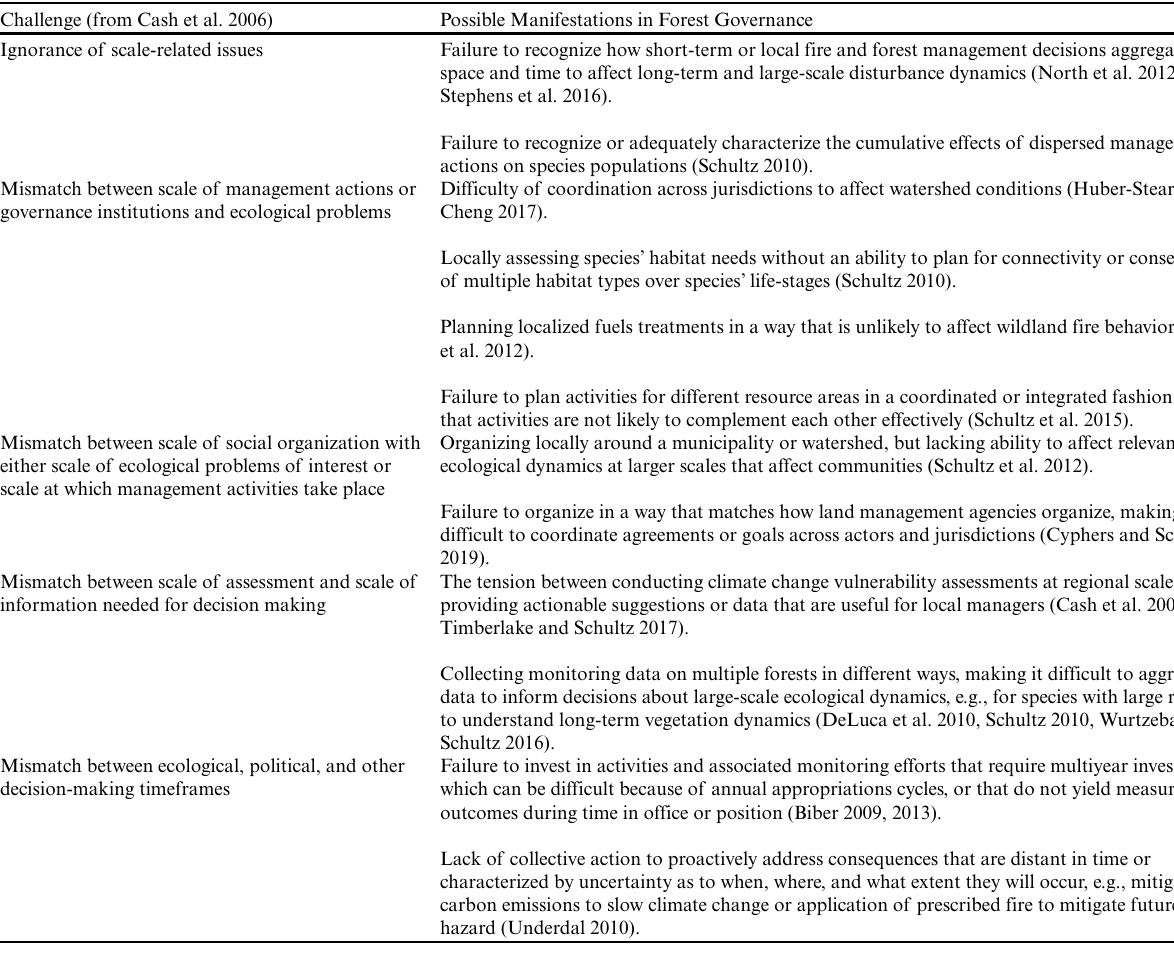
Table 1 . Types of scale challenges and examples from forest governance. Challenge (from Cash et al.